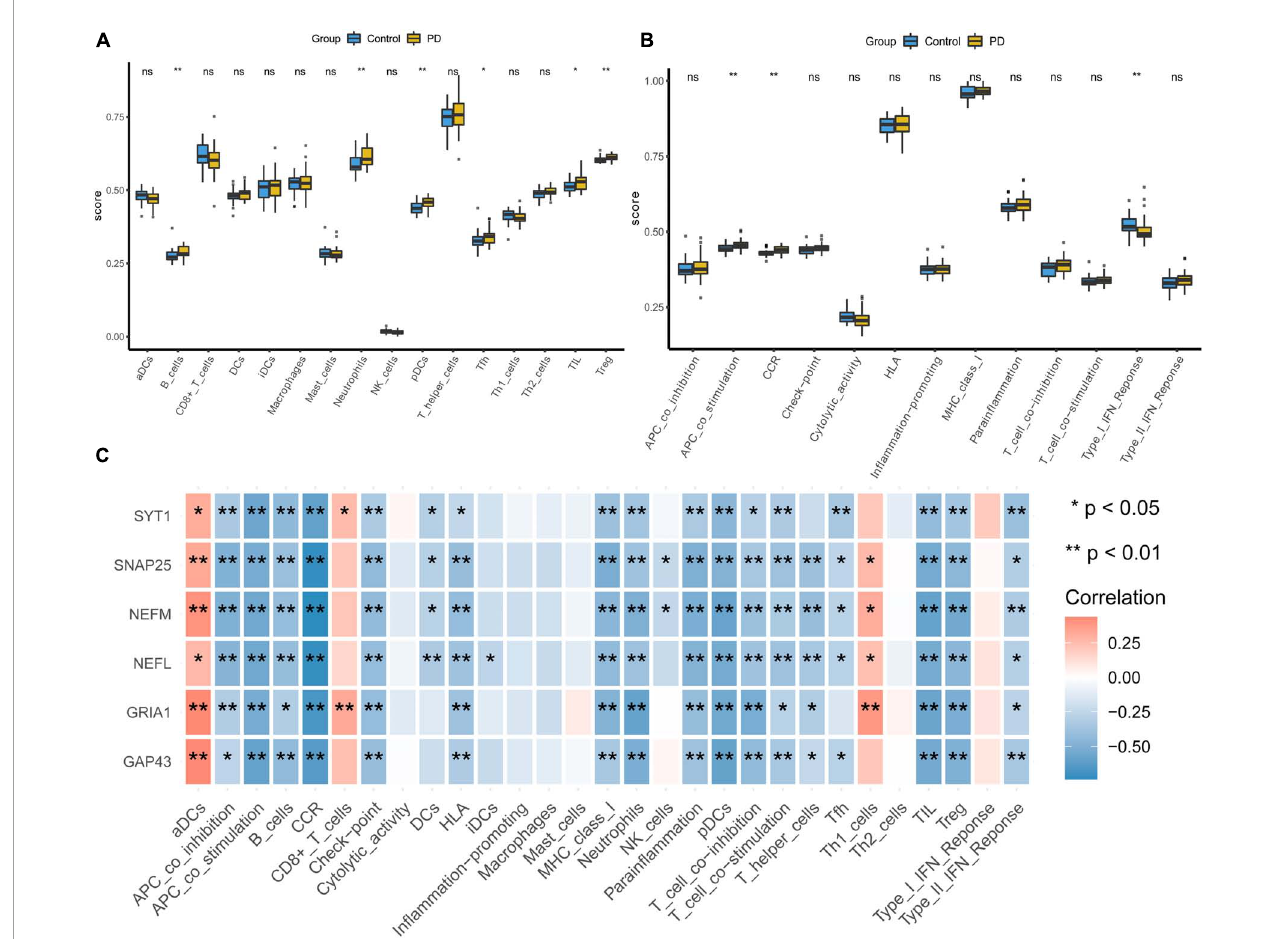
FIGURE8 Visualization and evaluation of immune infiltration levels based on ssGSEA. (A) Comparison of 16 immune cells between PD samples and control samples. (B) Box diagram of different immune function expression levels in the PD and control groups. (C) Pearson correlation analysis of 29 types of immune cells and immune-related functions with hub genes (* p < 0.05 and ** p < 0.01). PD, Parkinson’s